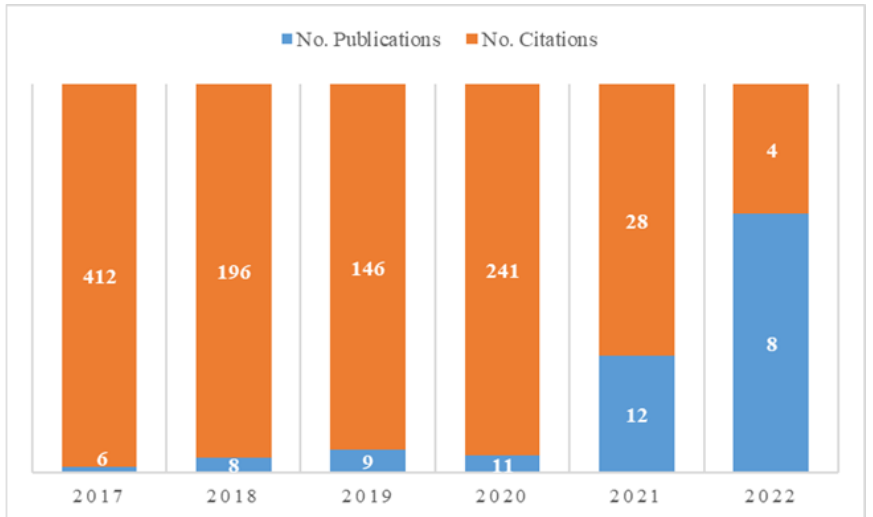
Figure 2. PRISMA 2020 flow diagram — Inclusion and exclusion criteria. Source: Authors’ elaboration.